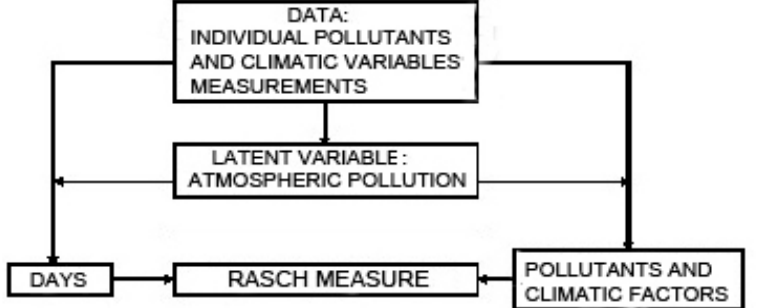
Figure 2. Schematic diagram of the stages involved in the formulation of the Rasch model.